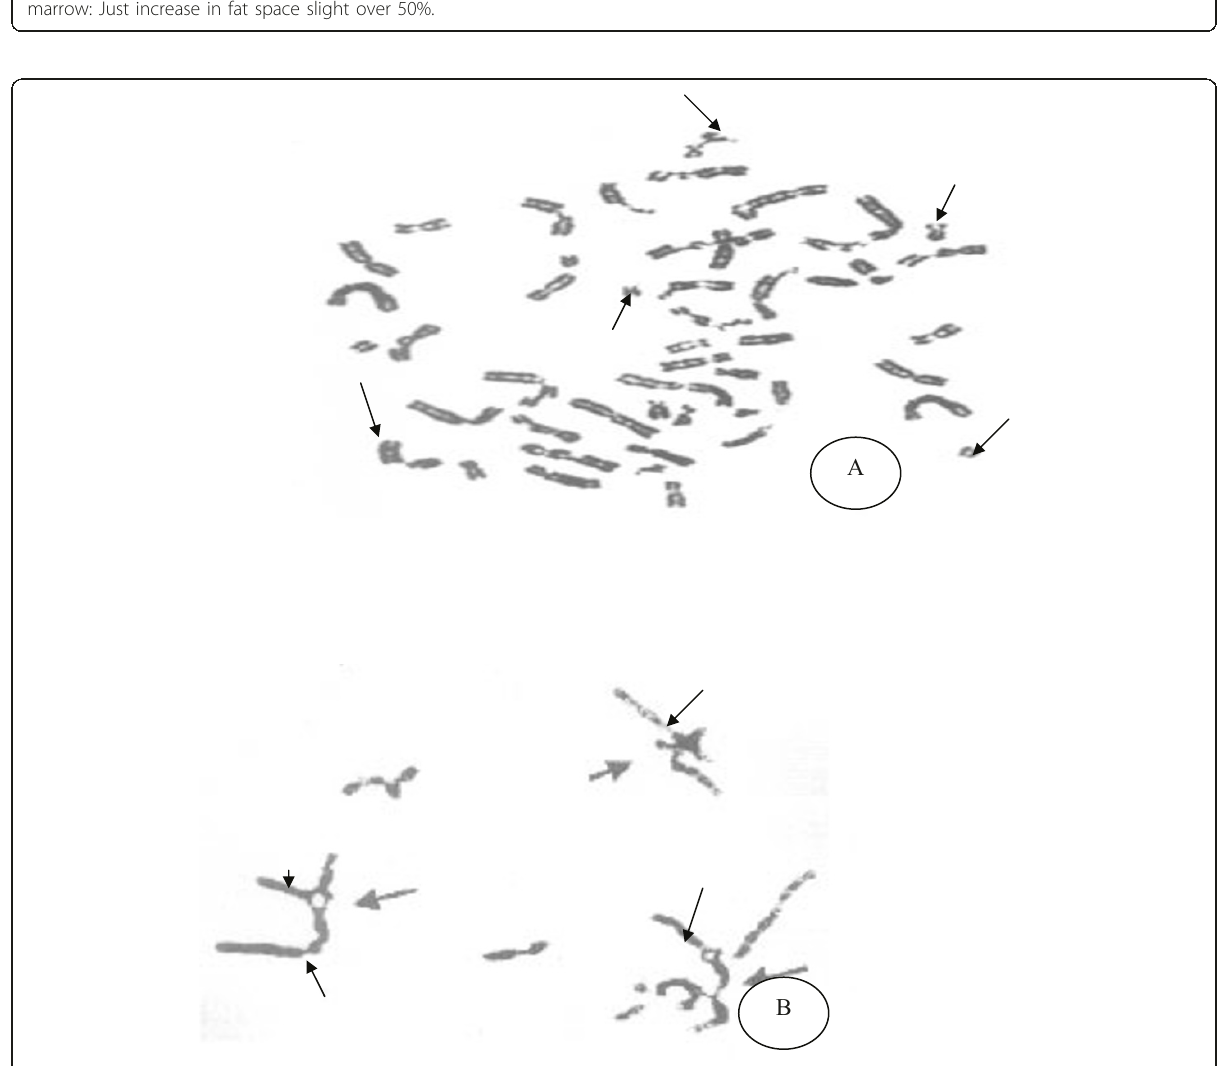
Figure 2 MMC test metaphase by Giemsa stain : (A) Increase chromosomal breakage the arrows denoting the area of breakage less than the width of chromatid in FA cases. (B) Radial formation are increased in FA